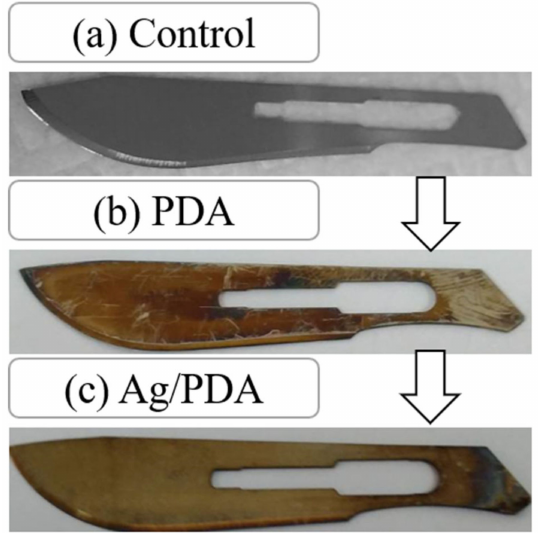
Figure A3. Photograph of ( a ) control; ( b ) PDA coated surgical blade ( c ) Ag/PDA modified surgical